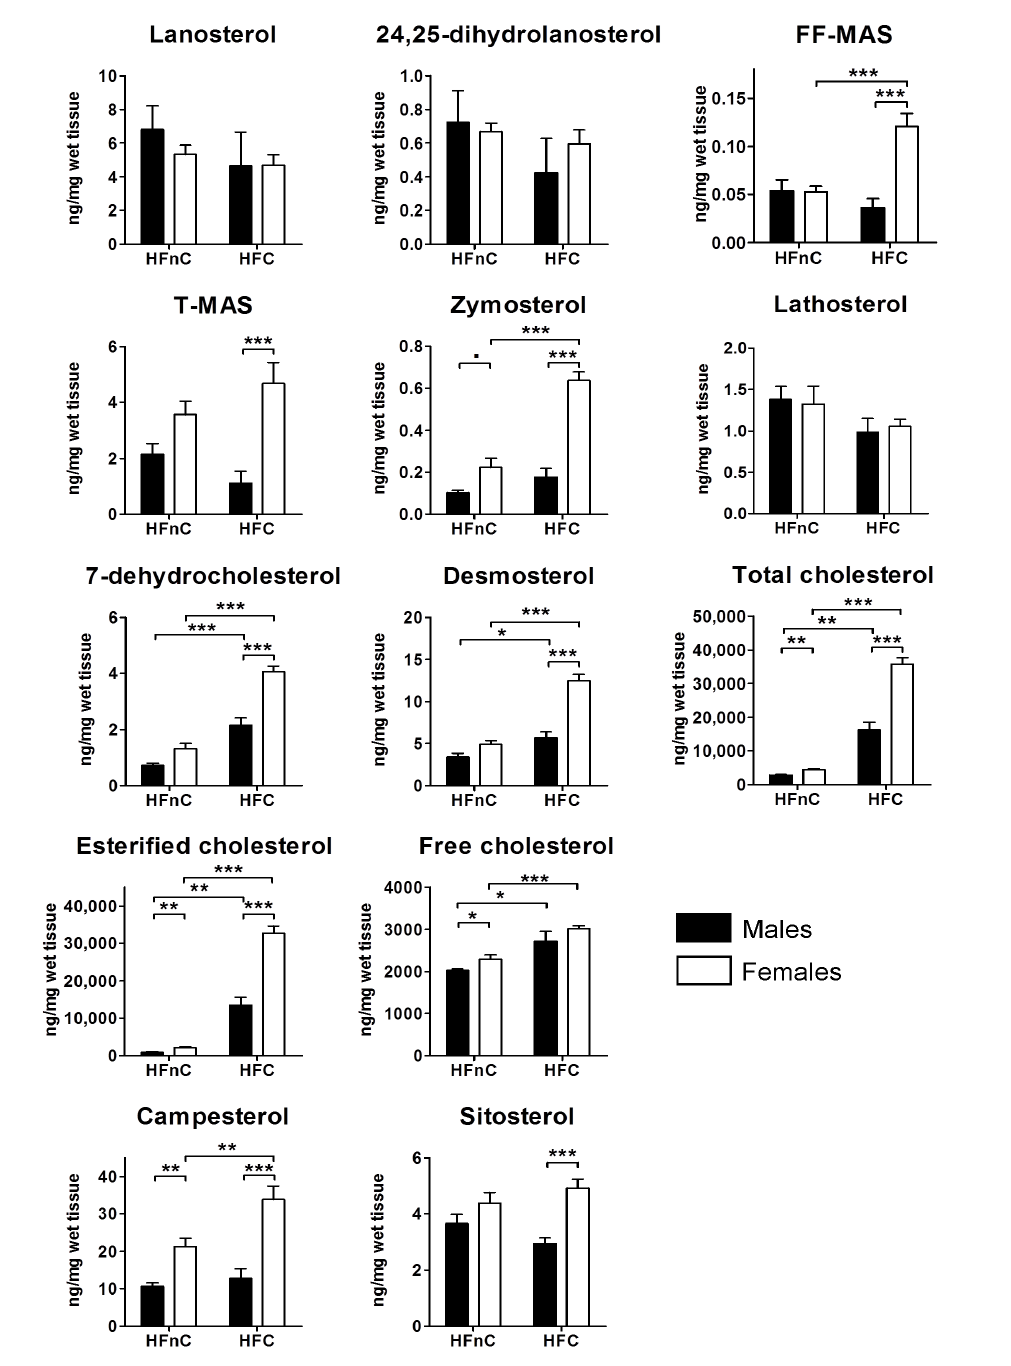
Figure 3. Hepatic contents of cholesterol, cholesterol intermediates and plant sterols expressed as ng/mg of wet liver tissue. Black columns represent male and white columns female mice. Error bars represent SEMs. N = 9–10; ˙ p < 0.1; * p < 0.05; ** p < 0.01; *** p <